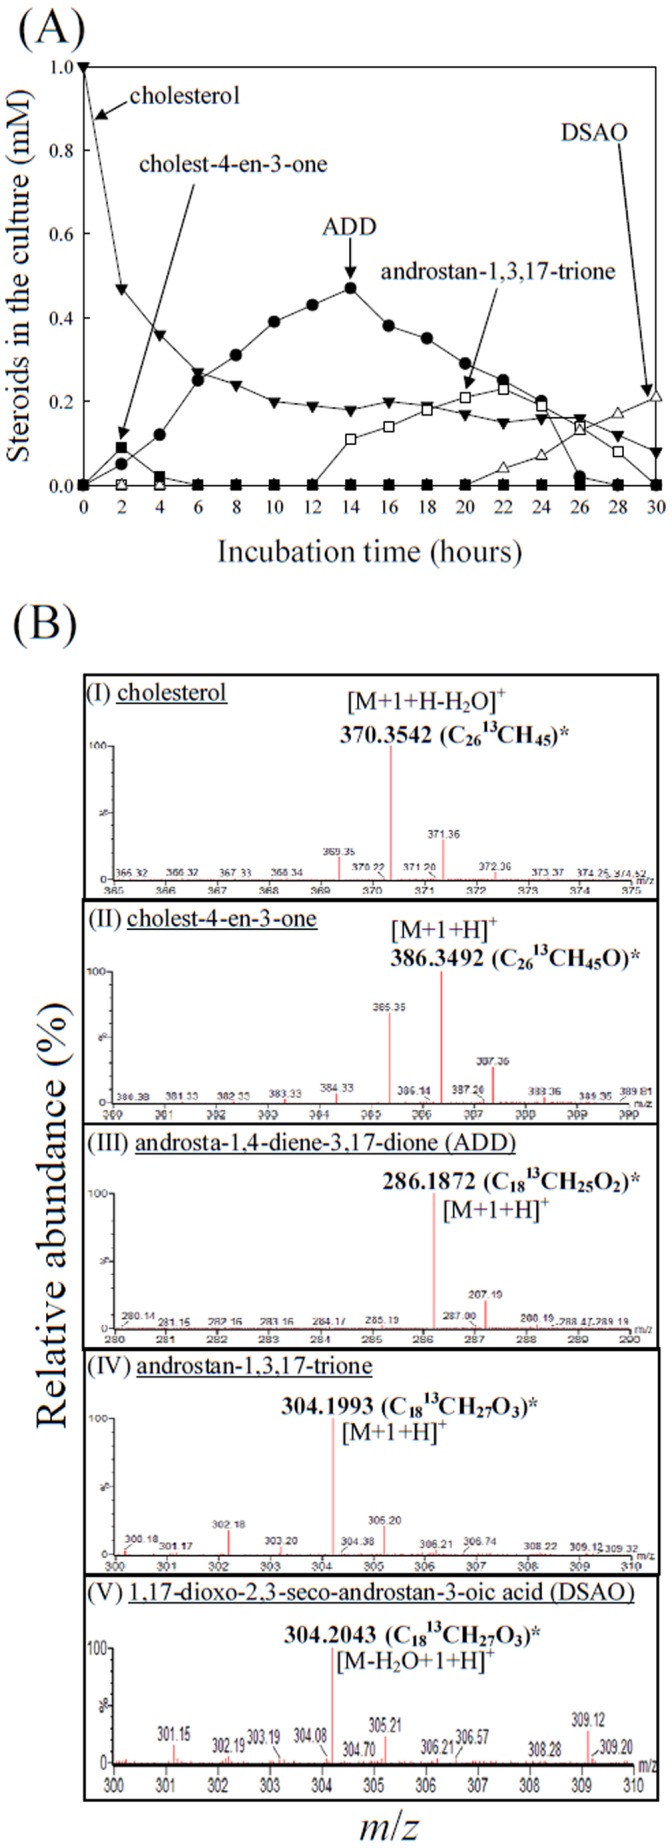
Aerobic cholesterol catabolism byS. denitrificans DSMZ 13999.(A) Time course of cholesterol consumption and intermediate production in a S. denitrificans fed-batch culture. [4C-13C]cholesterol (1 mM) was fed to a starved S. denitrificans culture (OD600nm = 0.9) after 2 mM cholesterol was exhausted. 0.1 mM of estrone was added as the internal control. The culture was incubation at 28°C for 30 hours with shaking (180 rpm). The steroids sampled at different time intervals were extracted with ethyl acetate three times, and the dominant intermediates were then separated and quantified using a reverse-phase HPLC system. Data are averages of three determinations (standard deviations <0.1). (B) High-resolution mass spectra of the dominant 13C-labeled intermediates detected in ethyl-acetate extracts of S. denitrificans cells grown on [4C-13C]cholesterol (1 mM). *The predicted elemental composition of individual intermediates was calculated using MassLynx™ Mass Spectrometry Software (Waters). See Figure S1 for other detected 13C-labeled intermediates derived from [4C-13C]cholesterol.